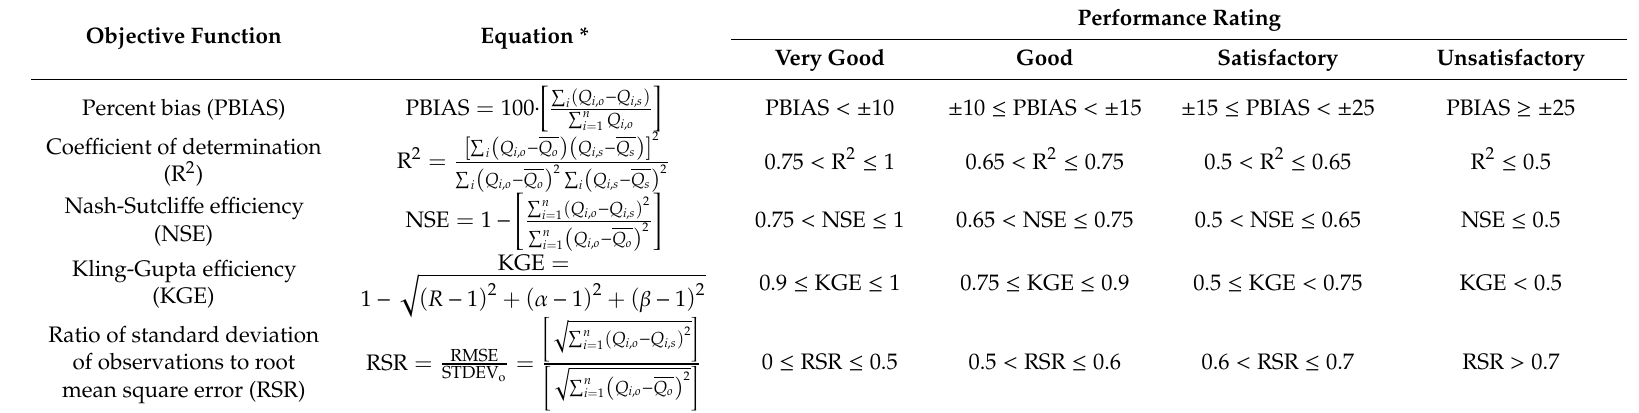
Table 2. Objective functions and their model performance rating used for outlets